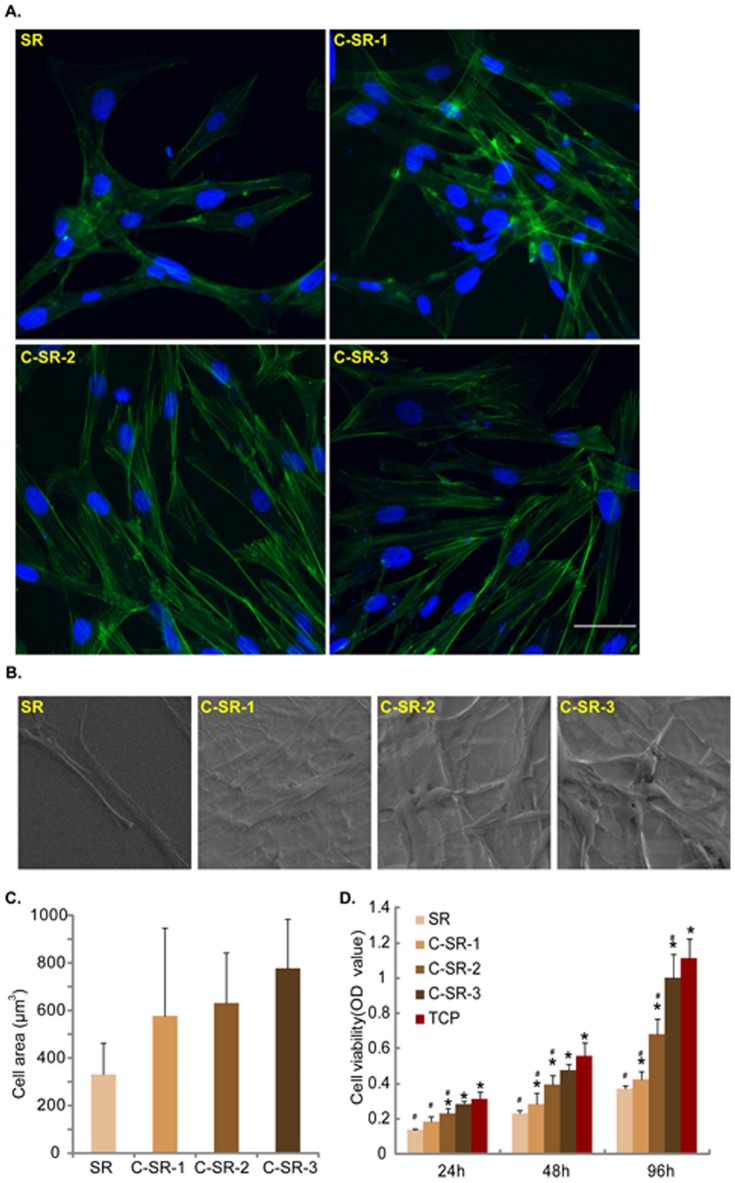
Human dermal fibroblasts cultured on C-SR grow faster and showed a more fibroblastic appearance.Dermal fibroblasts (1×106) were seeded in 6-well plate pre-coated with SR or three C-SRs (C-SR-1, C-SR-2 and C-SR-3). The cells were incubated in 37°C incubator for 48 hours for observation of cell morphology. (A) FITC-labeled actin tracer was used to observe cytoskeleton by immuno-fluorescence microscopy. Fibroblasts cultured on C-SRs had more and larger filopodia spreading out, and their microfilament stretched longer and arranged more regularly. (B) SEM images further demonstrated a more fibroblastic appearance of fibroblasts cultured on C-SRs. (C) Cell area depicted higher values for cells on C-SRs than those on SR. But the difference was not statistically significant between any two groups (p>0.05). (D) Dermal fibroblasts were cultured in 96-well plate (at a density 1×103 cells/well) for 24, 48 and 96 hours. The cell viability was analyzed by CCK-8 assay. The cell viability was also increased by C ion implantation. *p<0.05 The difference was statistically significant when the substrate was compared to SR at any time point. #p<0.05 The difference was statistically significant when the substrate was compared to TCP at any time point. Experiments in this figure were repeated three times, similar results were obtained each time. Bar = 20 µm. All data are expressed as mean ± SD (error bars).